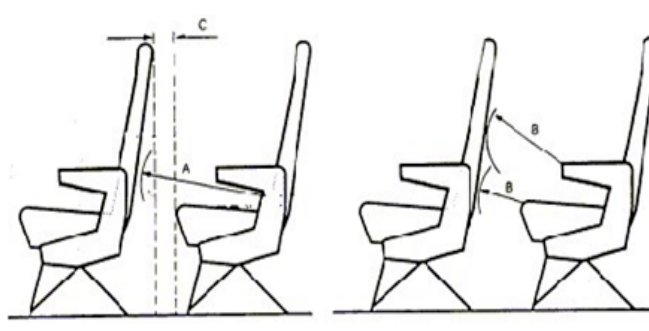
Figure 3. Distancing of aircraft seats [23].